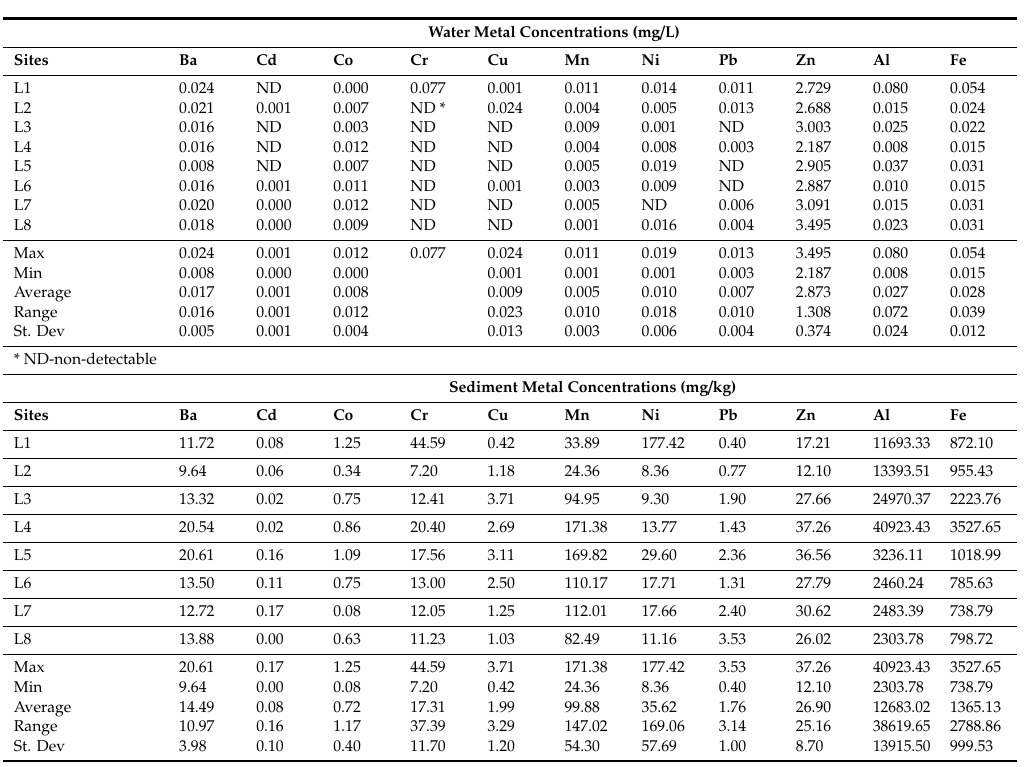
Table 2. Heavy metals concentrations and descriptive statistics in the water and sediments of Umm Al Quwain